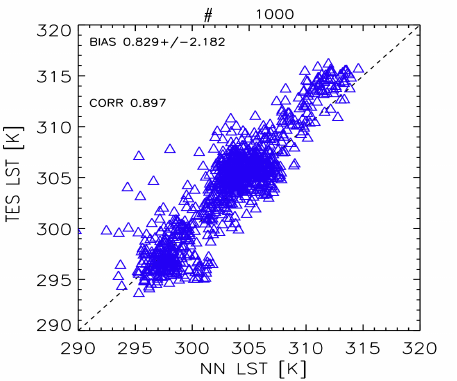
Figure 11. LST retrieved with TES algorithm vs. LST from DLIM over 1000 wheat